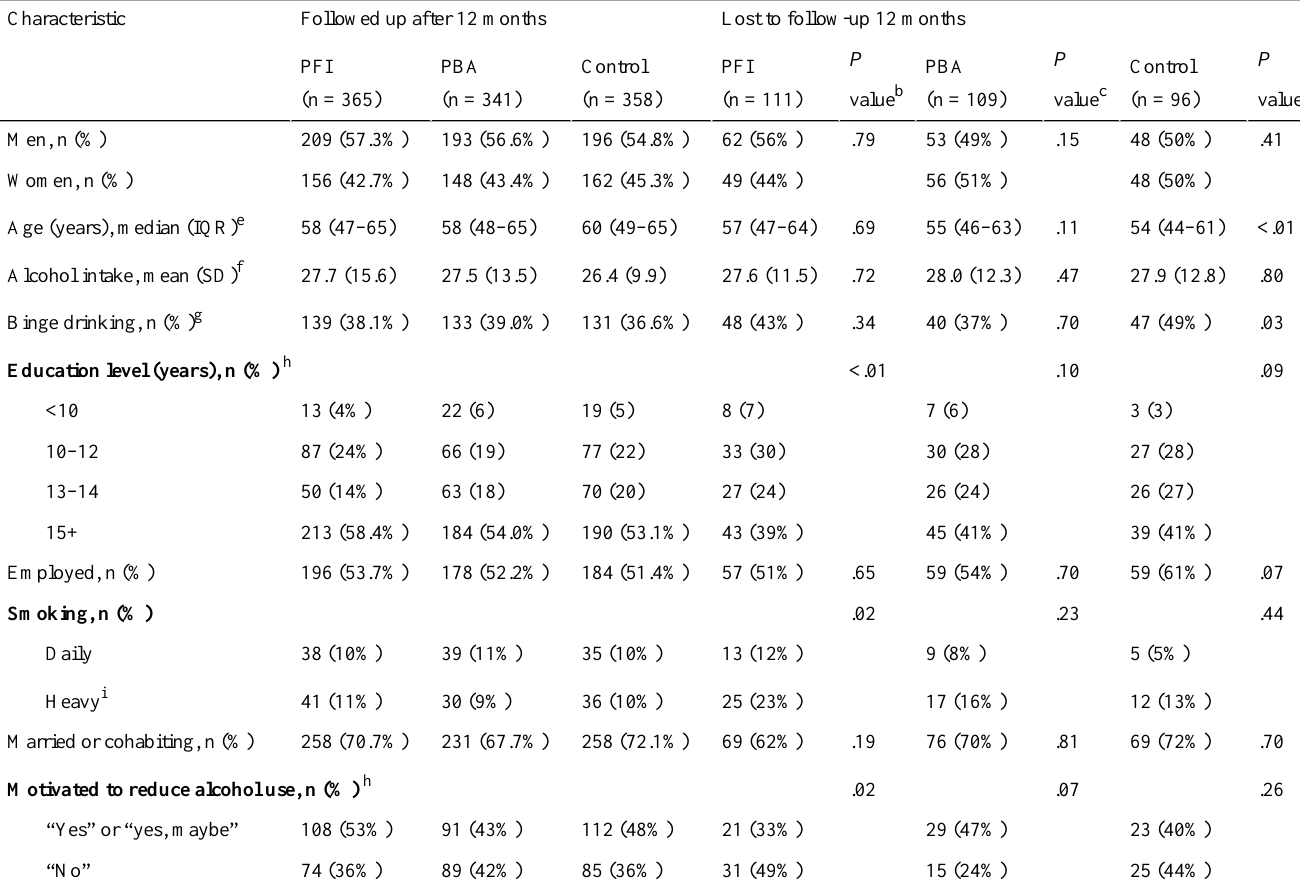
Table 3. Comparison of characteristics of participants randomly assigned to Internet-based brief personalized feedback intervention (PFI), Internet-based personalized brief advice intervention (PBA), or control group at baseline between those followed up after 12 months and those lost at 12-month follow-up. a